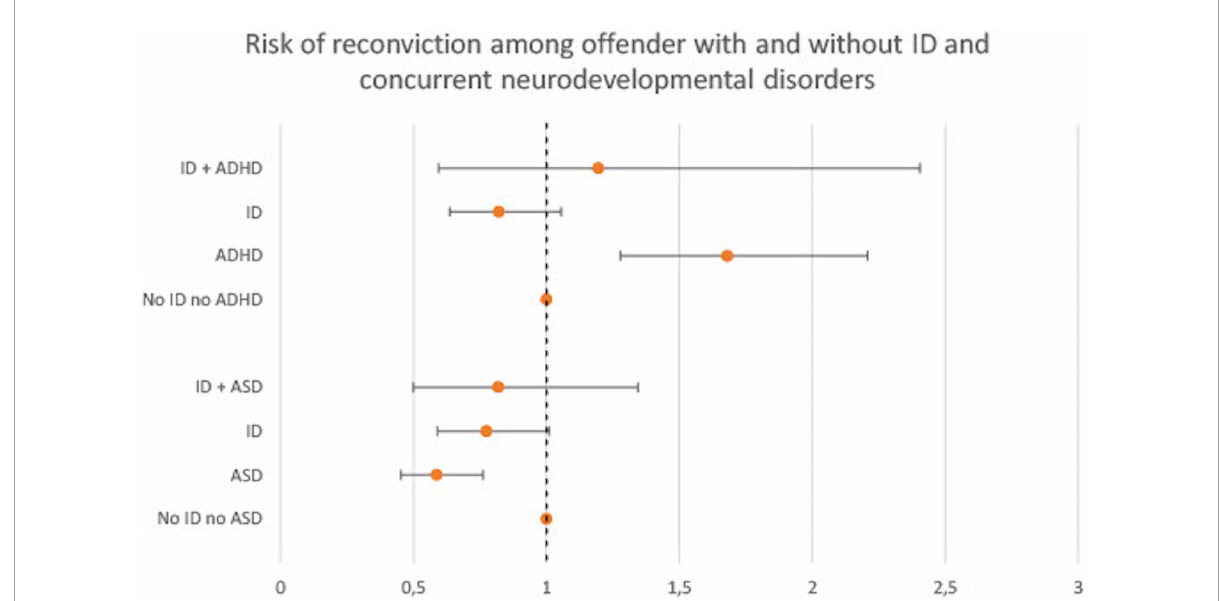
FIGURE2 Cox proportional hazard ratios (with 95% CI) for criminal recidivism associated with clinical variables among offenders with and without ID. Reference category for each group are offenders with neither ID nor the clinical variable (ADHD and ASD, respectively). ADHD, Attention Deficit Hyperactivity Disorder; ASD, Autism Spectrum